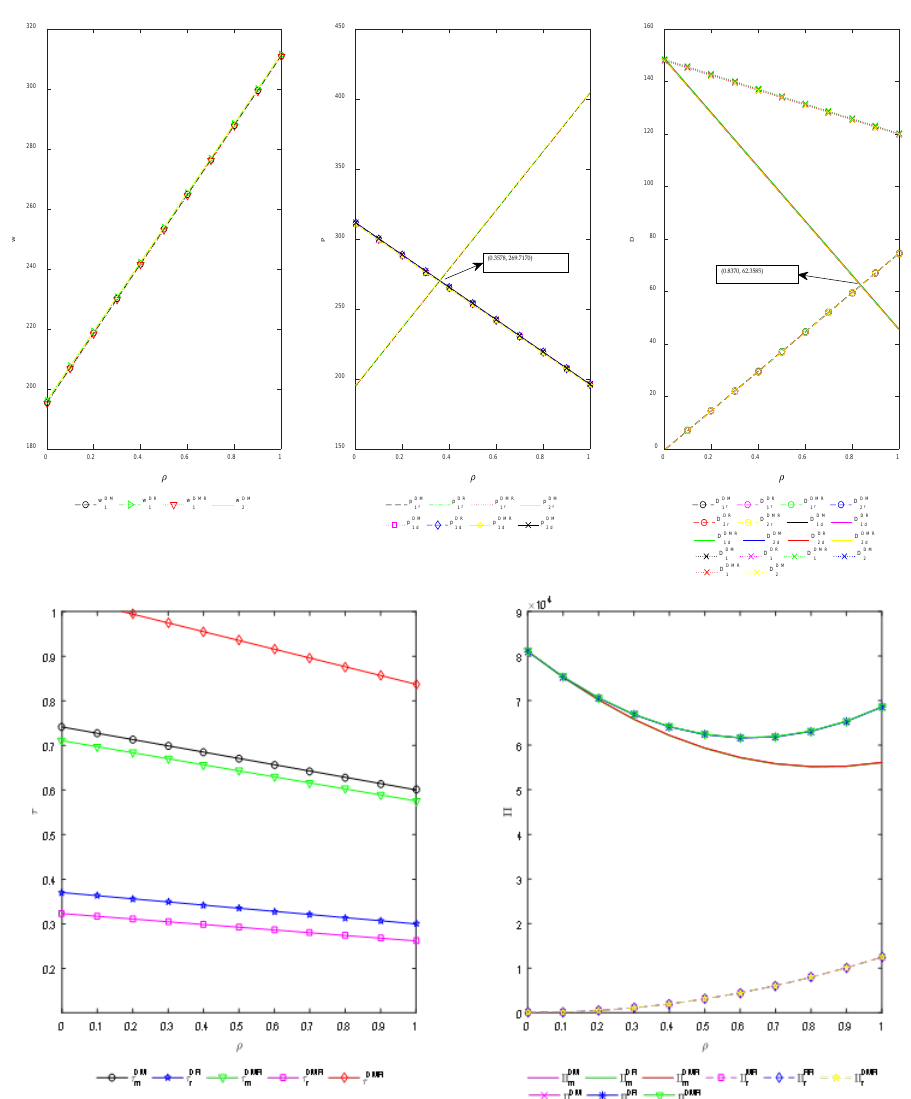
Figure 4. Changes of the wholesale price/selling price/market demand/collecting rate/profit with ρ . (c) Impact of sensitivity coefficient for self-price β [ ] 0.6,2 β∈ Setting